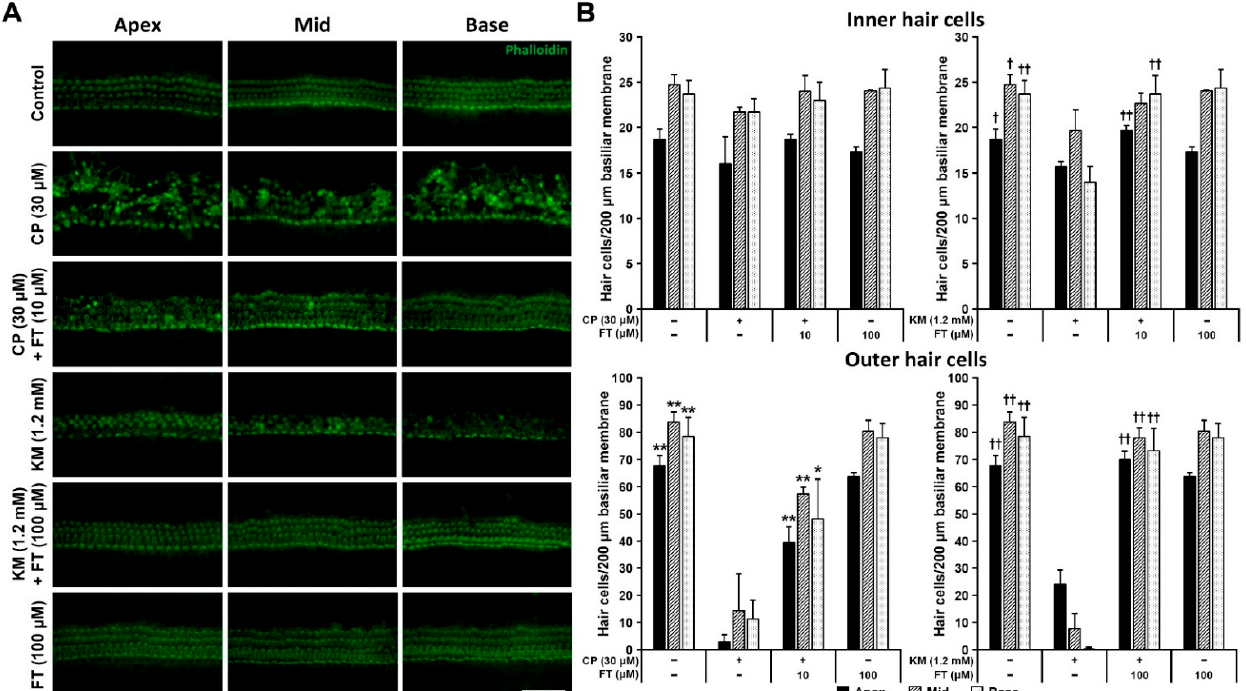
Figure 1. Effect of FT pretreatment on CP-, KM-induced ototoxicity in hair cells. ( A ) Images of fluorescence in mouse cochlear explants from Control, CP, CP + FT, KM, KM + FT, and FT groups ( n = 3, each). Stereocilia bundles of IHCs and OHCs were stained with phalloidin (green). ( B ) Number of surviving IHCs (upper) and OHCs (lower) along a basilar membrane length of 200 μ m in each region. All groups contained 9 mice. Data are shown as mean ± SD. *, † p < 0.05; **, †† p < 0.01 (student’s t ‐ tests) compared with the CP group. CP: cisplatin, KM: kanamycin, FT: fursultiamine. Scale bar, 50 μ m.